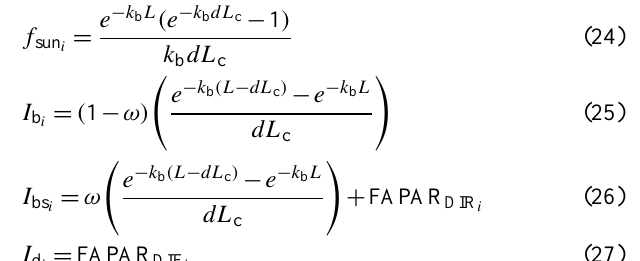
Table 3. Summary of options available for the calculation of canopy photosynthesis. Option Leaf to canopy scaling Radiation N profile Inhibition of leaf 1 Big leaf Beer’s law Beer’s law no 2 Multi-layer Two stream Constant through canopy no 3 Multi-layer radiation with Two stream Constant through canopy no two classes (sunlit and shaded) for photosynthesis 4 Multi-layer Two stream Decreases through canopy yes 5 Multi-layer including sunlit and Two stream with Decreases through canopy yes shaded leaves in each layer sunfleck